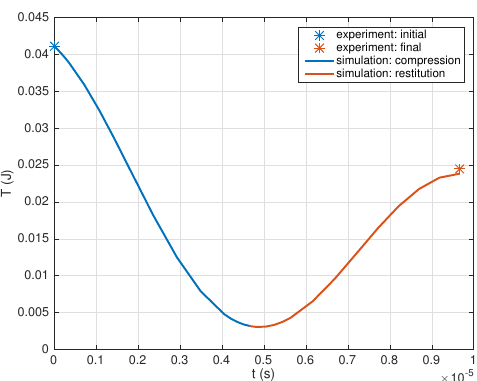
Figure 8. Experimental and simulated kinetic energy during an oblique impact on